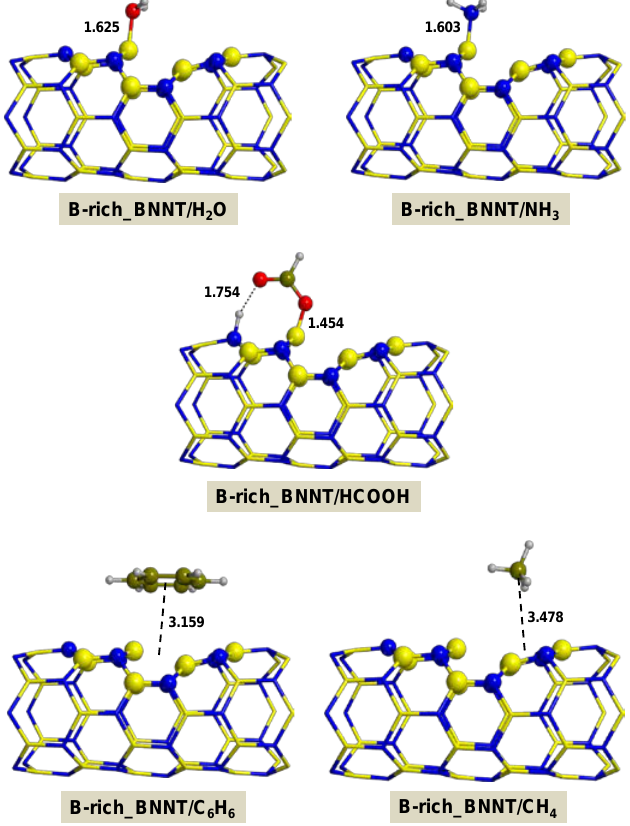
Figure 5. B3LYP-D2* optimized structures of the probe molecules interacting with B-rich_BNNT. Bond distances are in Å. The distances for B-rich_BNNT/C 6 H 6 are those between the centroid of the aromatic ring and the plane defined by the closest nonagon ring; for CH 4 , they are between the C atom and the plane defined by the closest pentagon ring.